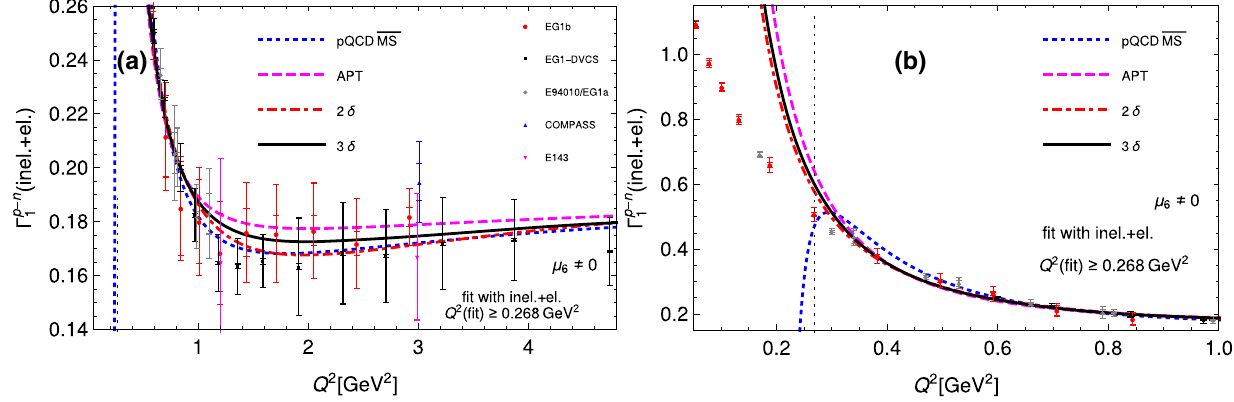
− n ( Q 2 ) inel . + el . . The lower j 1